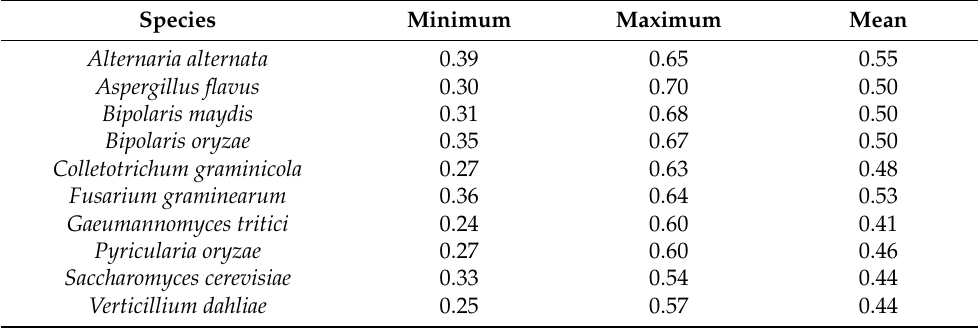
Table 4. The mean and range of translational selection indices for zinc binuclear cluster gene family coding sequences in Ascomycetes fungi and model yeast